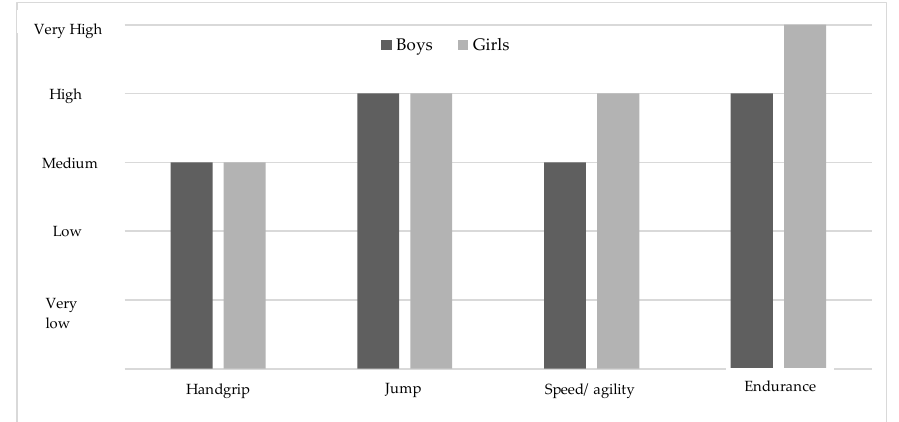
Figure 2. Mean levels of physical fitness variables based on the average levels established by Ortega et al. (2011) [59].